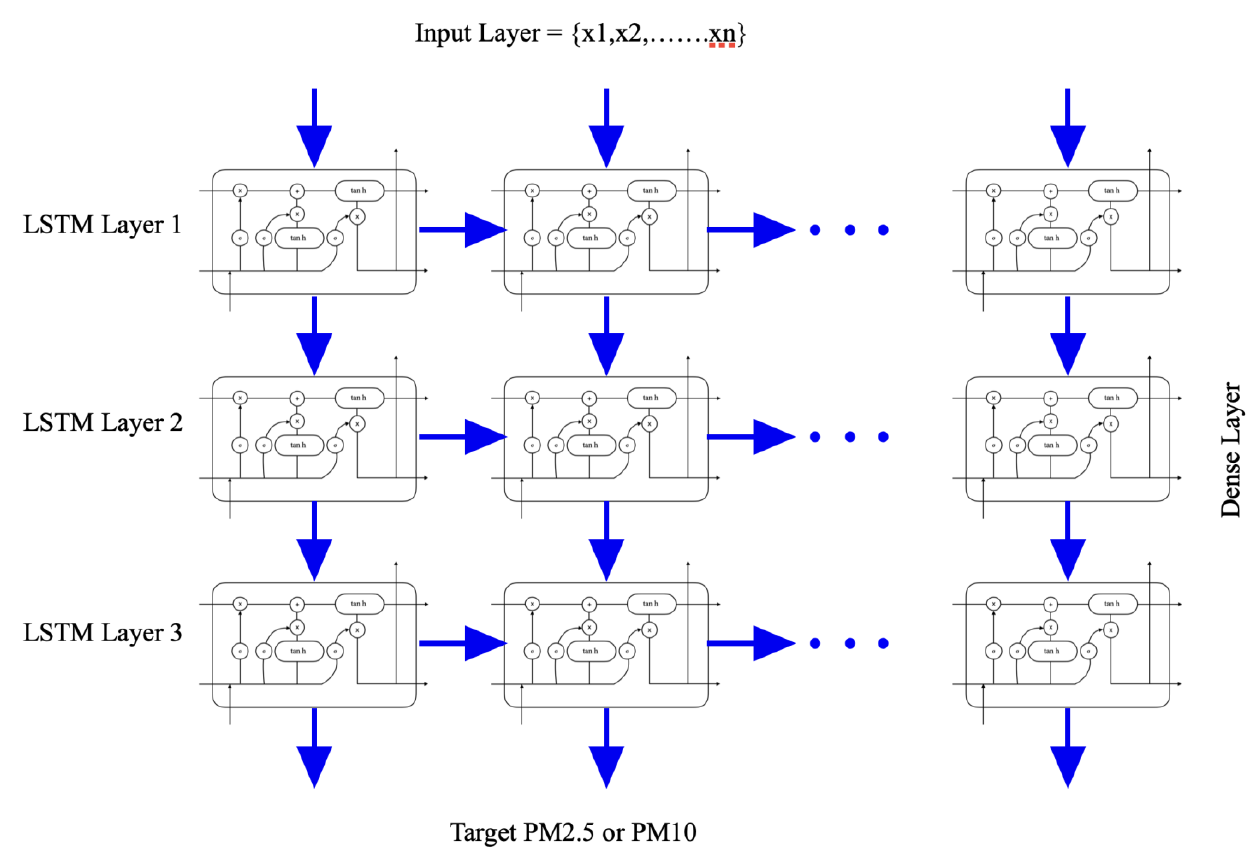
Figure 2. Seminal stacked LSTM